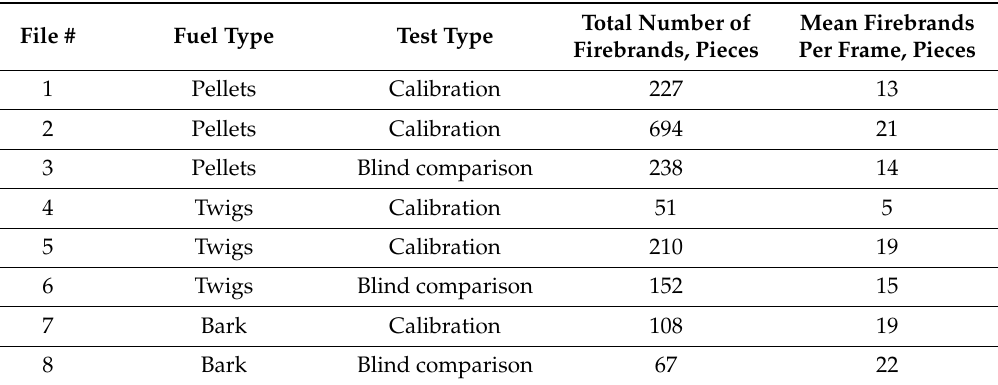
Figure 6. Example of selected thermograms/frames: ( a – c ) are the small, medium, and large number of firebrands (pellets), respectively. Table 2, with the characteristics of annotated videos, is given below. Table 2. Annotated video database.